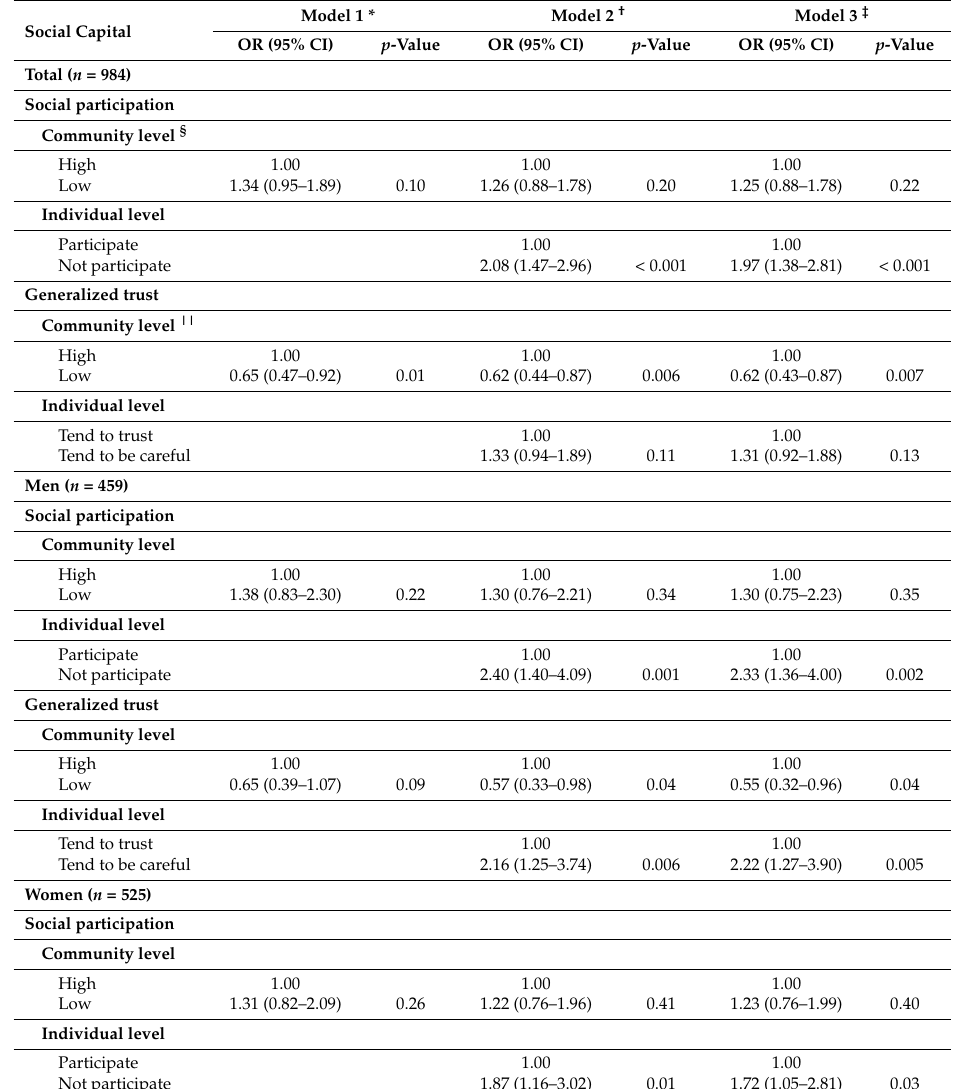
Table 3. Association of community and individual level social capital with composite outcome: results from multilevel logistic regression